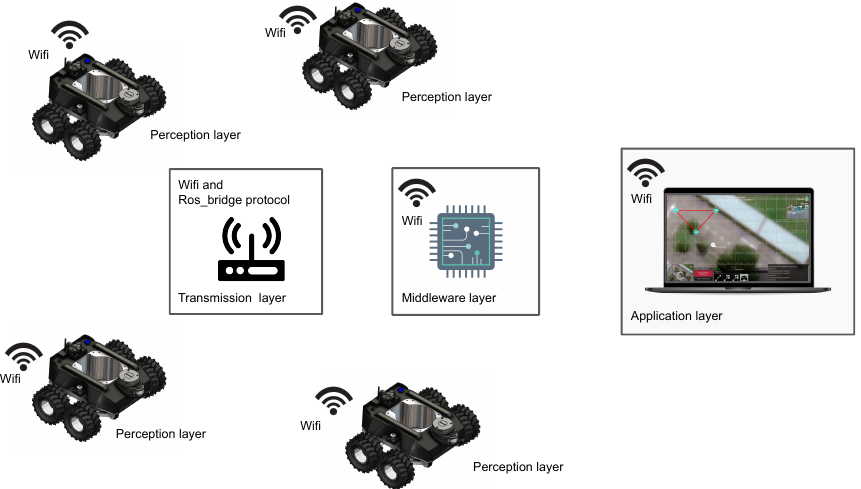
Figure 7. Overview for a Raptor drain inspection